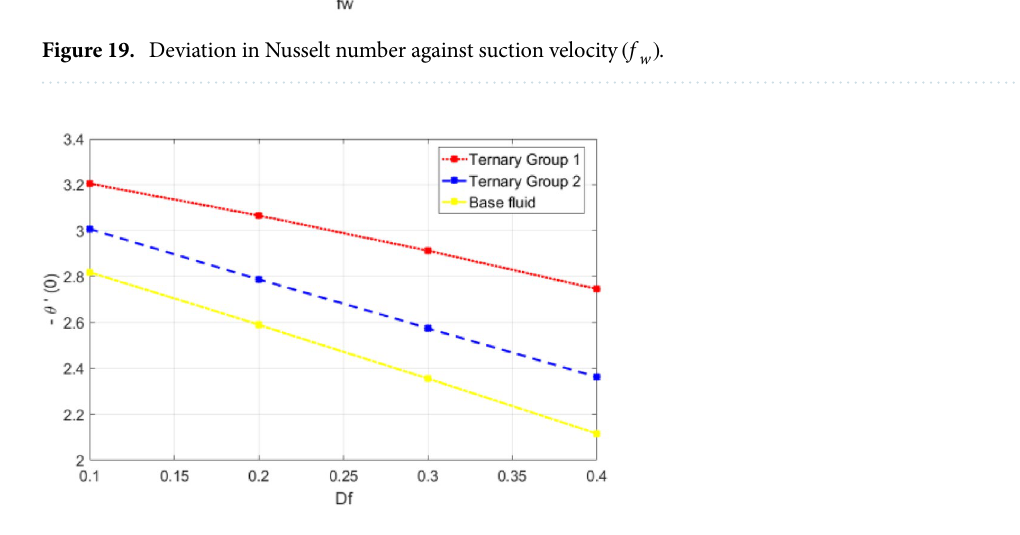
Figure 20. Deviation in Nusselt number against Dufour number ( Df )